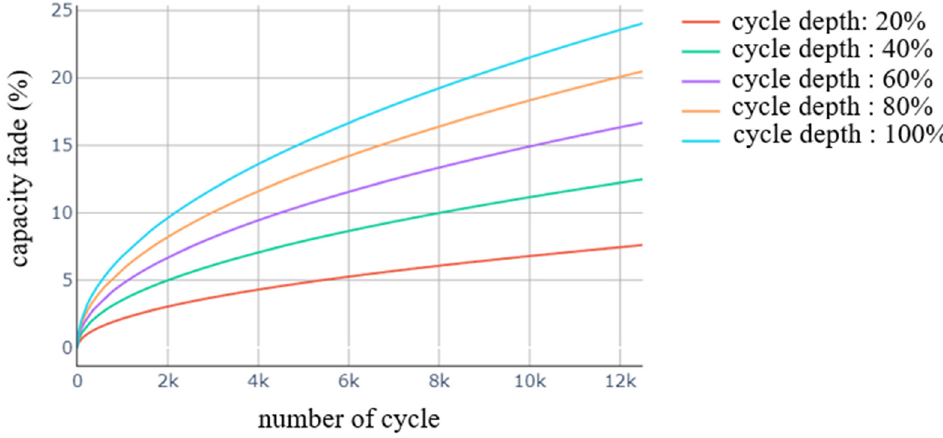
Figure 6. Cycling aging curves.